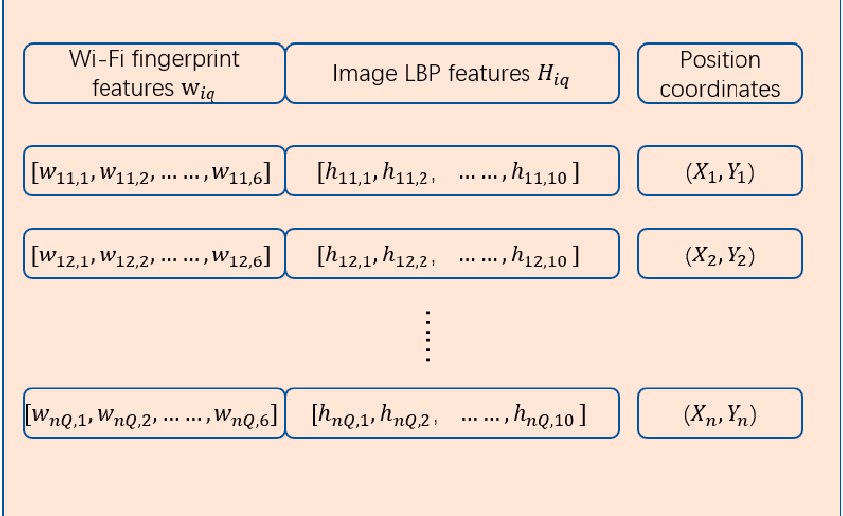
Figure 2. Merged fingerprint